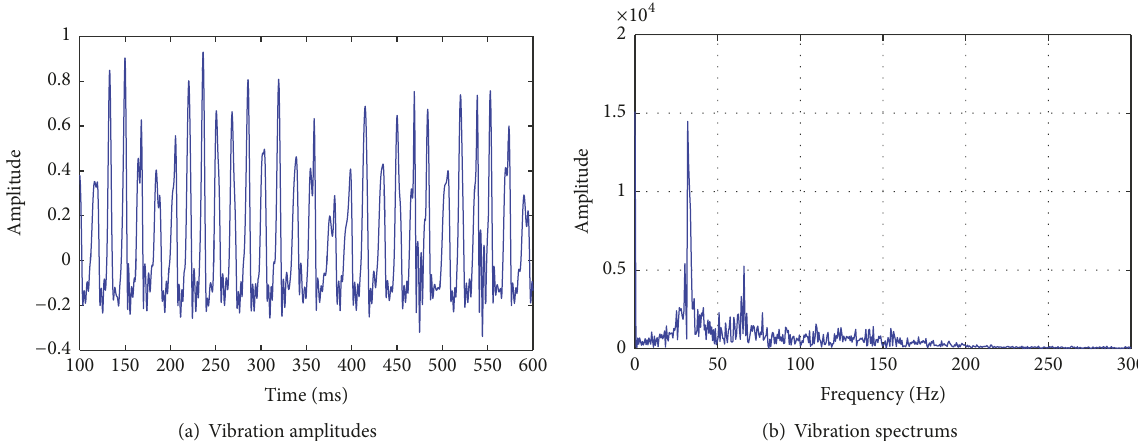
Figure 13: The horizontal direction response of the position of pedestal looseness ( 𝜆 = 0.3 , 𝛿 = 0.0001 m).